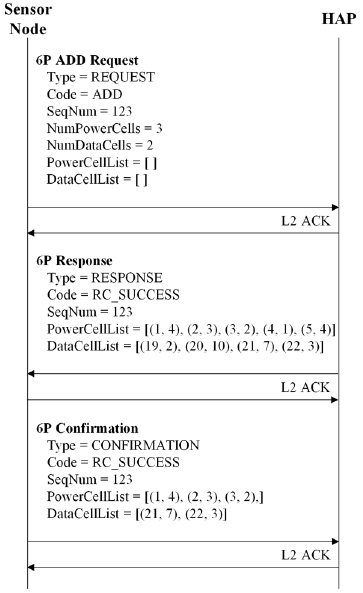
Figure 5. Example of the three-step 6P